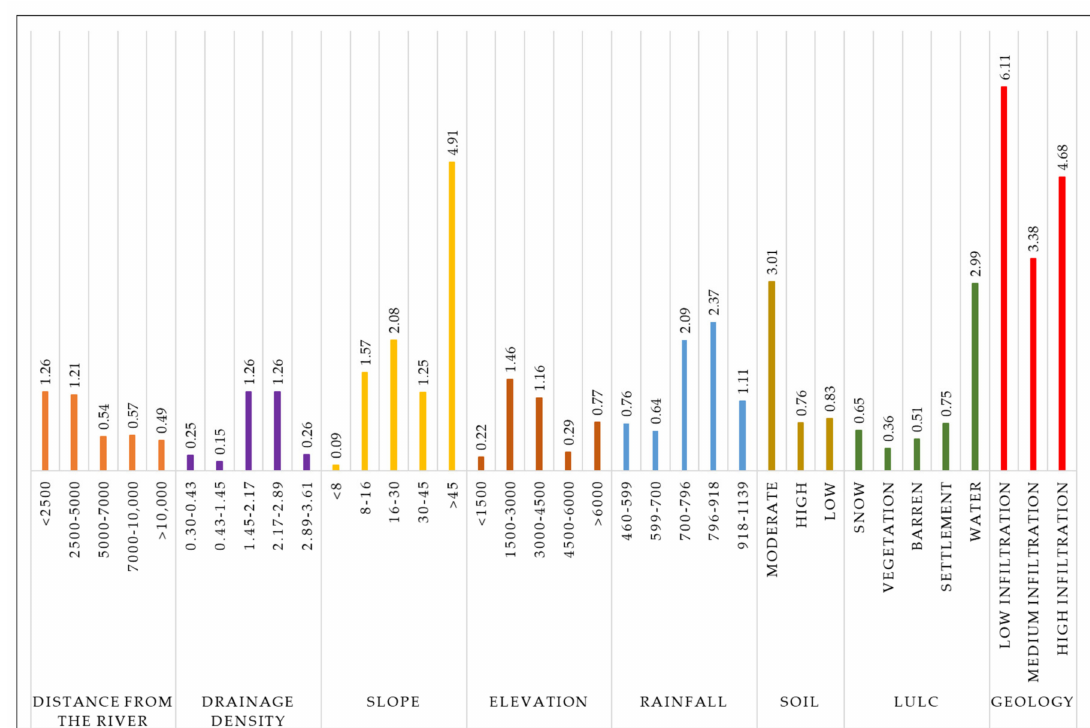
Figure 5. Flood-inducing factors for mapping flood susceptibility based on class frequency